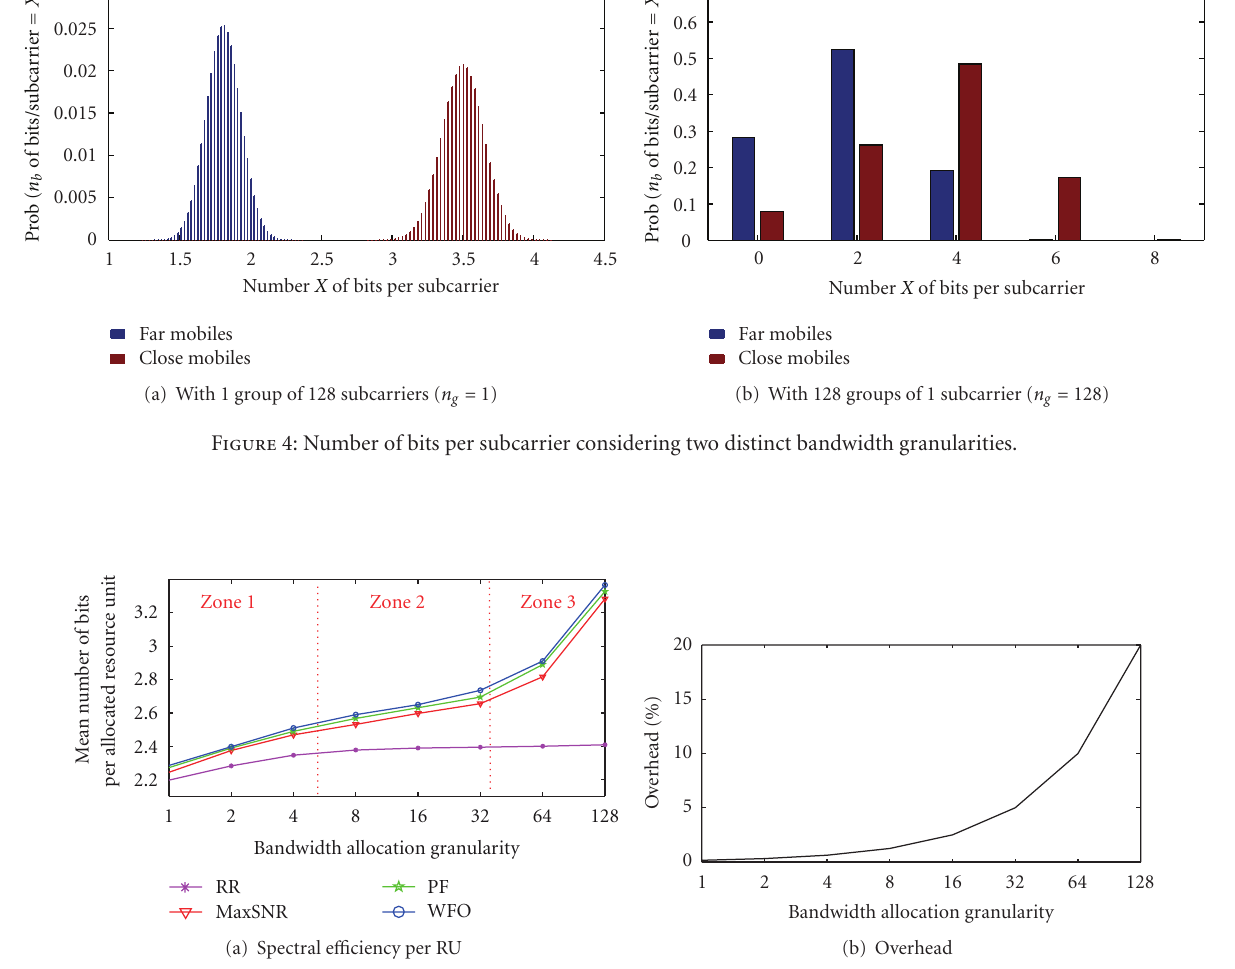
Figure 5: Impact of bandwidth granularity on spectral e ffi ciency and